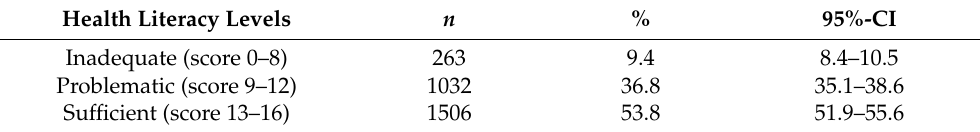
Table 2. Health literacy levels ( n =